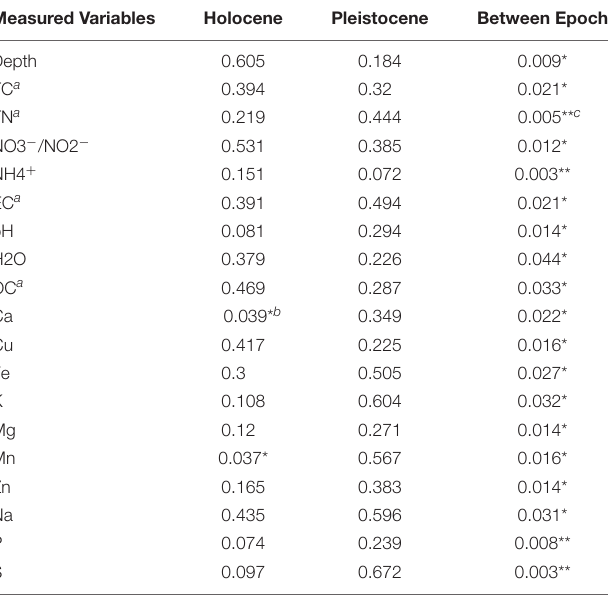
TABLE 3 | The probability values calculated based on Wald’s generalized estimating equation in the context of a negative binomial many generalized linear model